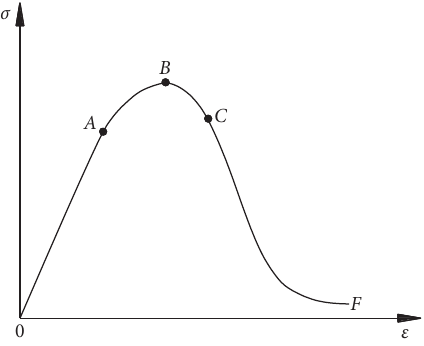
Figure 4: Envelope of typical dynamic stress-strain